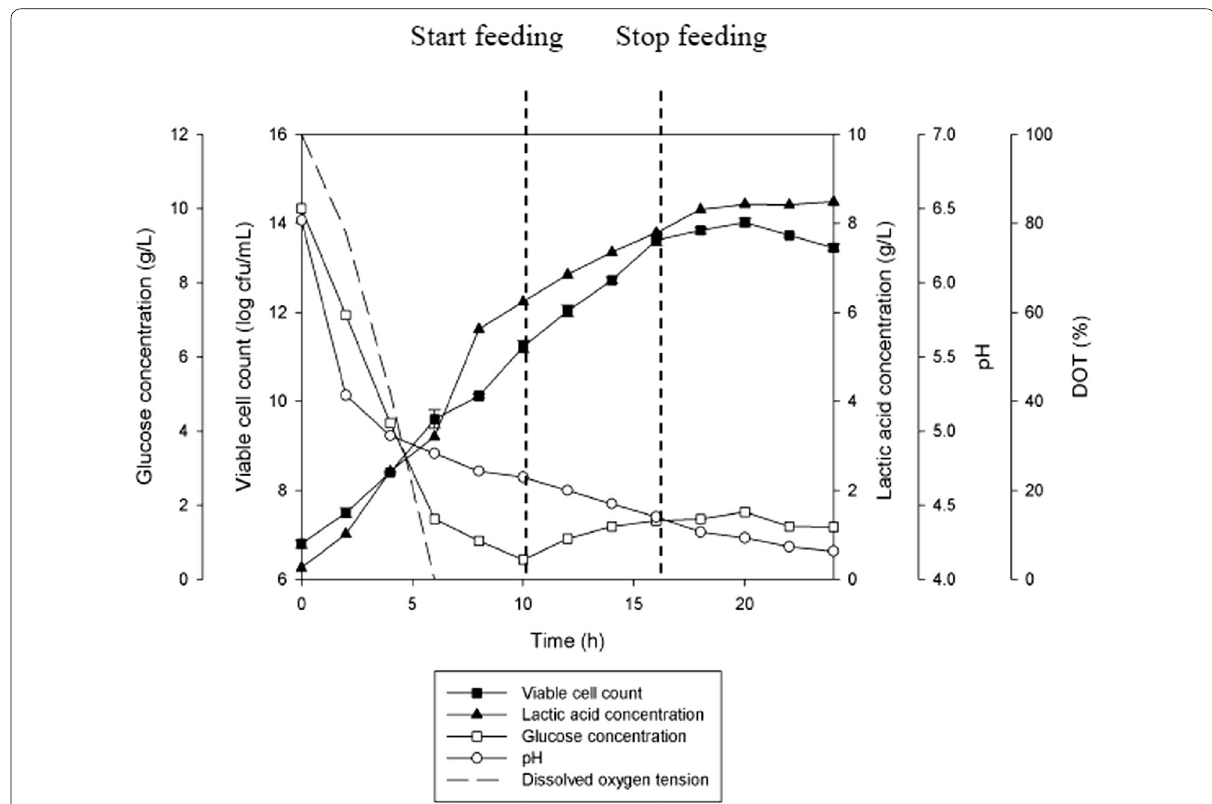
Fig. 6 The time course of constant fed-batch fermentation of P. acidilactici in 2 L stirred tank bioreactor with in situ addition of 10 g/L IRA 67 resin. The error bar represents the standard deviation about the mean (n